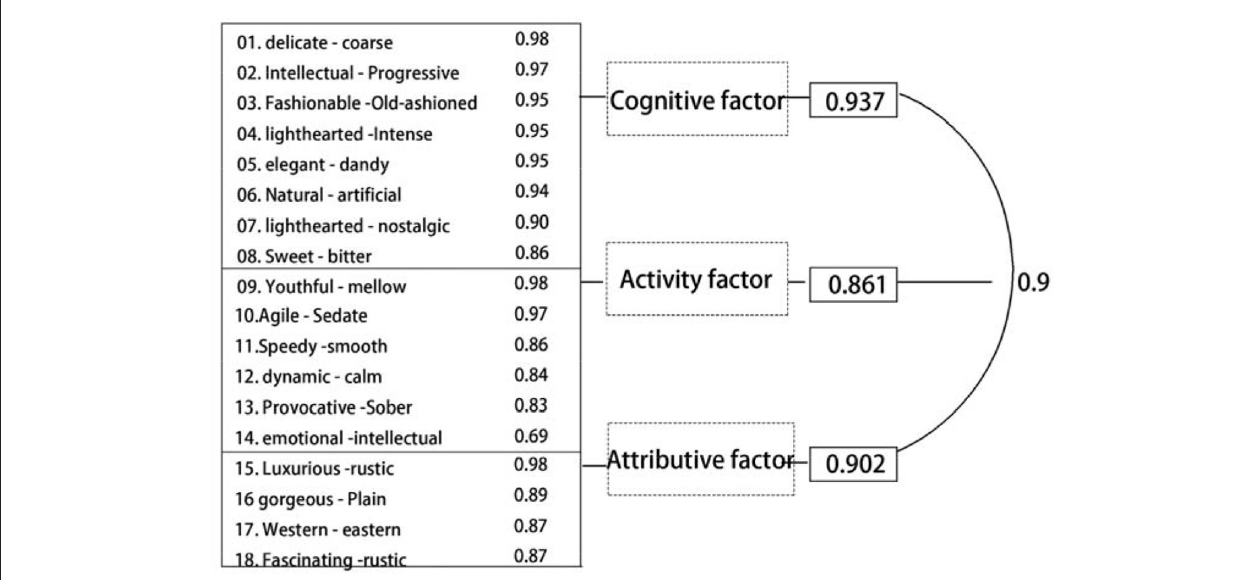
FIGURE 9 | Numerical analysis diagram of three common factors.